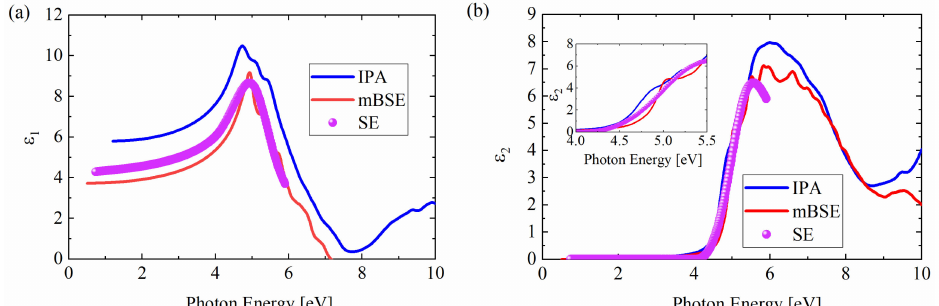
Figure 4. The theoretically predicted: ( a ) real part; ( b ) imaginary part, of the dielectric function of Ta 2 O 5 using the independent-particle approximation (IPA) and model Bethe–Salpeter equation (mBSE) approach as compared with SE data at normal conditions. The inset of ( b ) is the enlarged view in the energy spectral range between 3.5 eV and 5.5